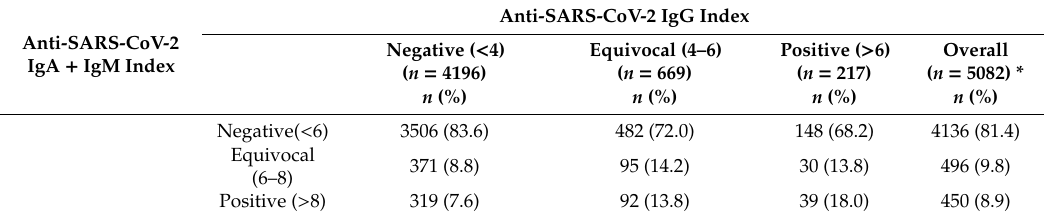
Table 2. Relationship between anti-SARS-CoV-2 IgG and anti-SARS-CoV-2 IgM + IgA indexes (values are added up in columns) ( n = 5082).